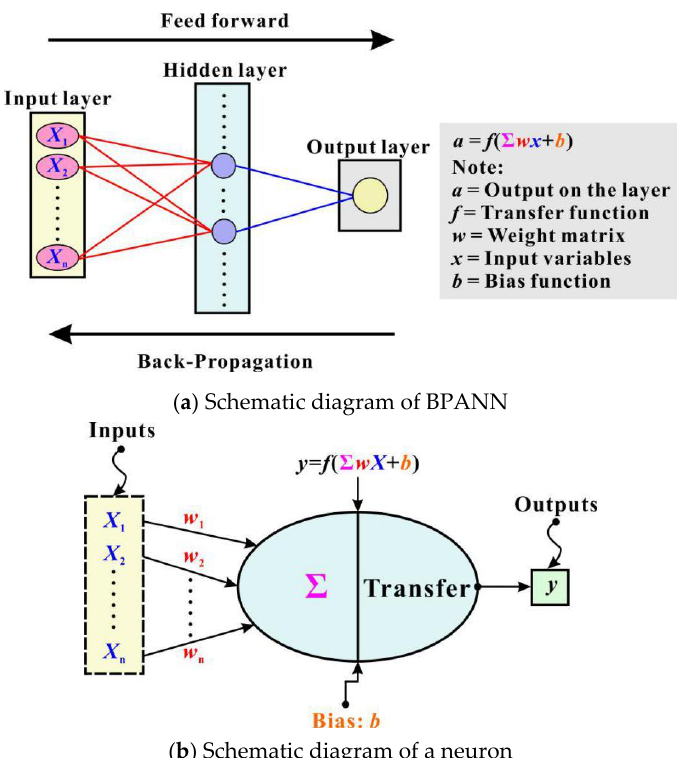
Figure 3. Illustration of BPANN